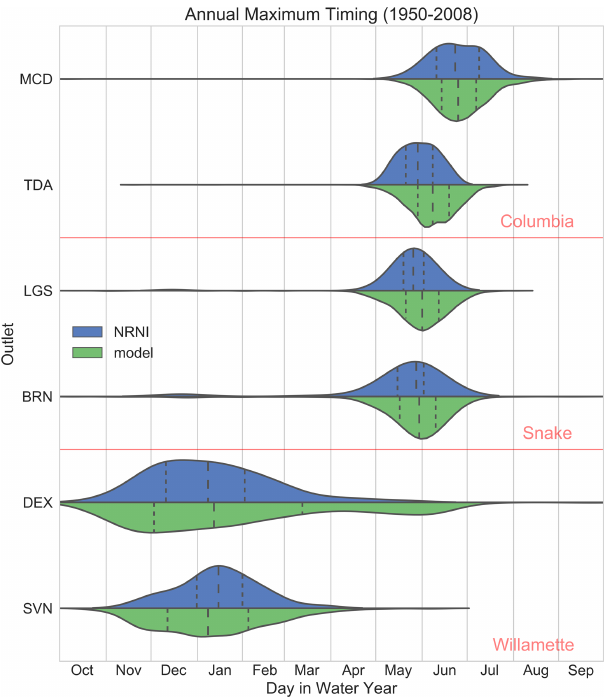
Figure 4. Statistical representations of the variation through the wa- ter year of the timing of flood events, 1950–2008, for NRNI (blue) and the 40 simulations of 1950–2008 with the climate–hydrology modeling system (green). To create each curve, the dates of the five highest streamflows in the period of record are tallied, and the resulting distributions smoothed. Long dashed lines indicate me- dian date; short dashed lines indicate the lowest and highest quar- tiles. MCD: Mica Dam (upper Columbia River); TDA: The Dalles (lower Columbia River, between the confluences of the Snake and Willamette rivers); LGS: Little Goose (lower Snake River); BRN: Brownlee; SVN: T. W. Sullivan (lower Willamette River near Port- land); DEX: Dexter (Middle Fork Willamette